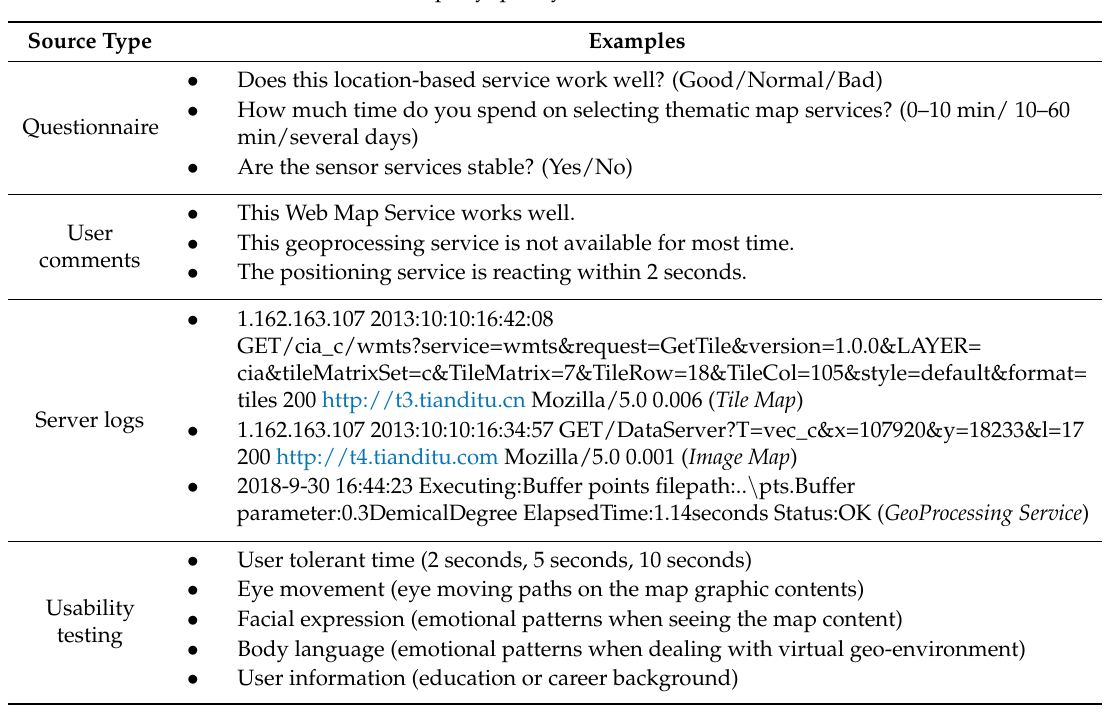
Table 3. Four exemplary quality data sources of user